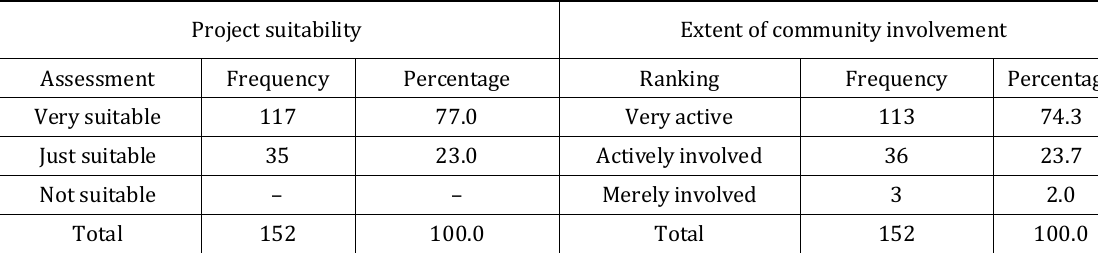
Table 3. Project suitability and extent of community involvement